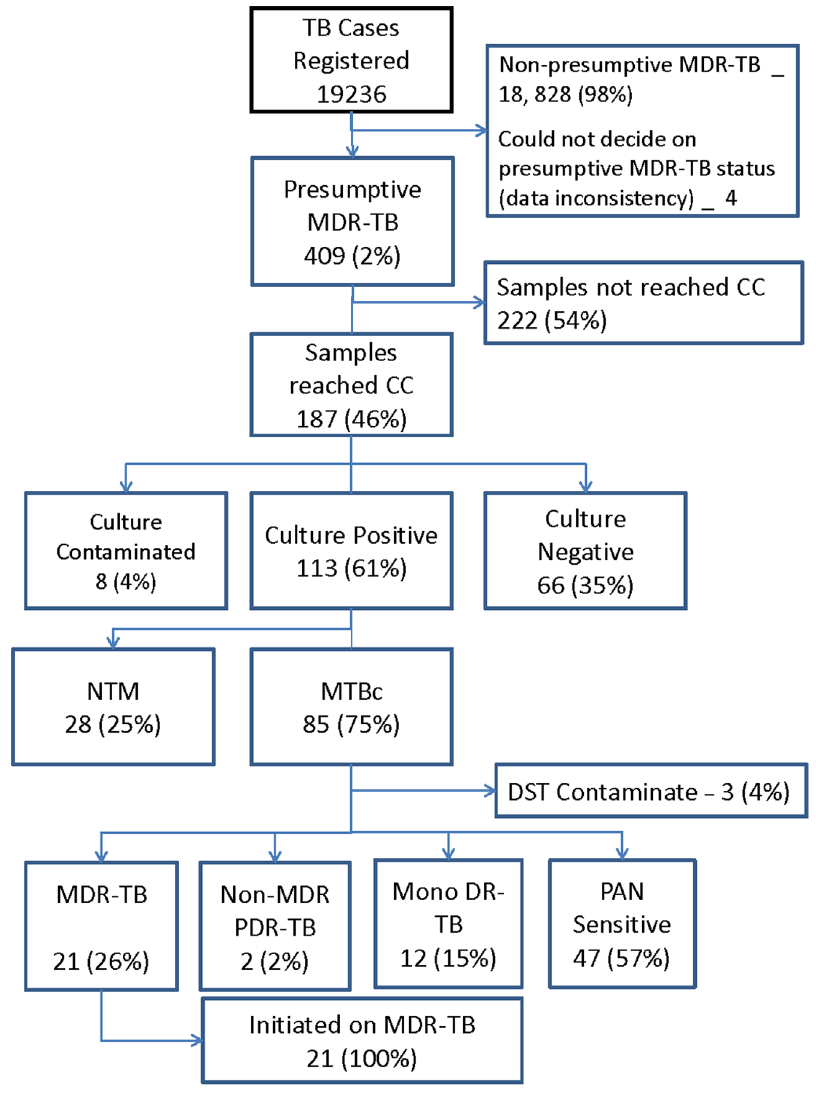
Figure 1. Status of linking presumptive MDR-TB patients to diagnostic and MDR-TB treatment services in Cambodia (2011). CC=Culture center, MTBc=Mycobacterium Tuberculosis complex, NTM=Non tuberculosis mycobacteria, DST=Drug Sensitivity Testing, MDR- TB=Multi drug resistant tuberculosis (resistant at R & H), PDR-TB=Poly drug resistant tuberculosis (resistant more than one but not R & H together), MonoDR-TB=Mono drug resistant